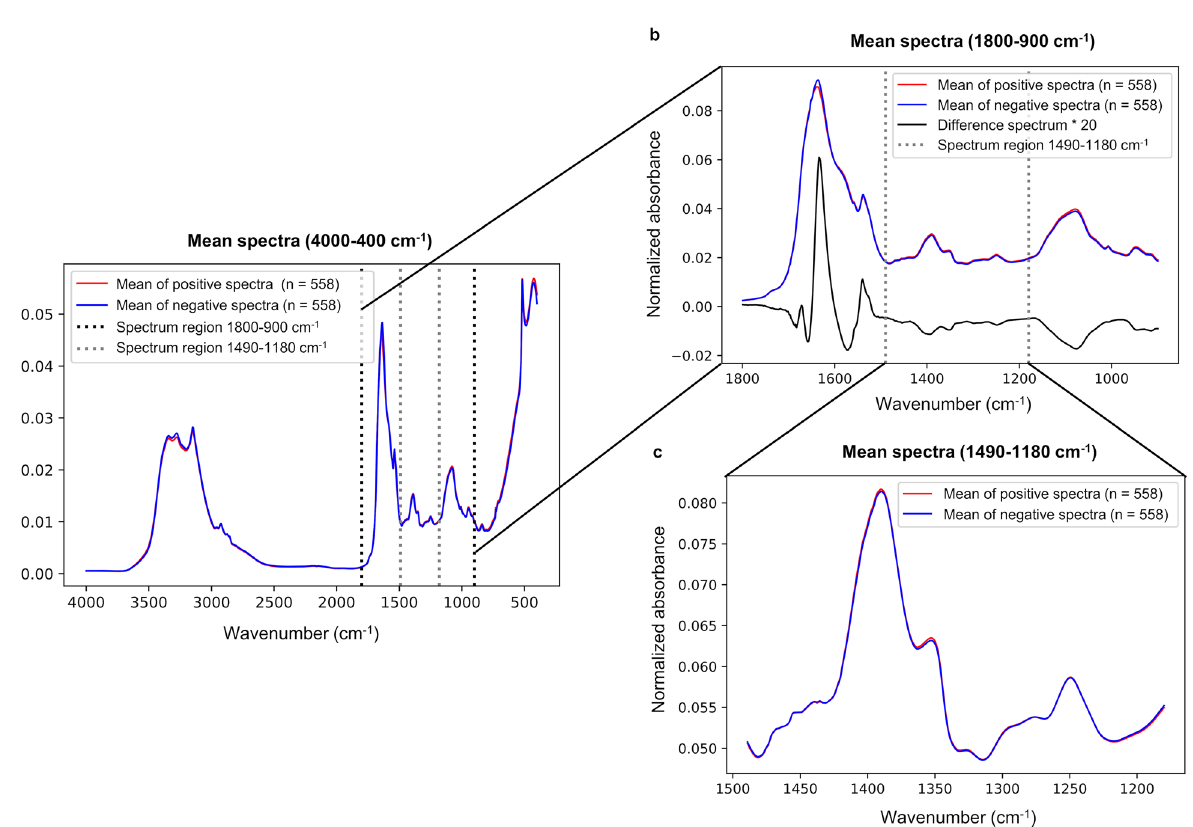
Figure 3. Mean spectra of positive and negative groups from different spectral regions. Vector normalization was applied before calculating the mean spectra. ( a ) Full mean spectra (4000–400 cm −1 ) from positive and negative groups. Also, spectrum regions of 1800–900 cm −1 and 1490–1180 cm −1 are marked. ( b ) Mean spectra from positive and negative groups from the fingerprint region, or spectrum region of 1800–900 cm −1 . Difference spectrum from the fingerprint region multiplied by factor of 20 is presented to illustrate differences between the sample groups in the fingerprint region. Spectral region of 1490–1180 cm −1 is also marked, ( c ) Mean spectra from positive and negative groups from the spectrum region of 1490–1180 cm −1 . Only minor spectral changes were visually observed between the sample groups in the spectral region of 1490–1180 cm −1 , although the diagnostic performance in the cross-validation setup was almost identical than with the whole fingerprint region (Tables 1, 2 for the spectral region of 1490–1180 cm −1